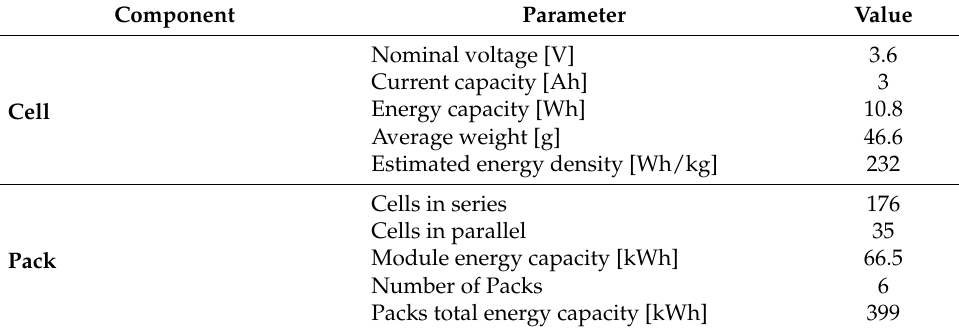
Table 2. Battery pack